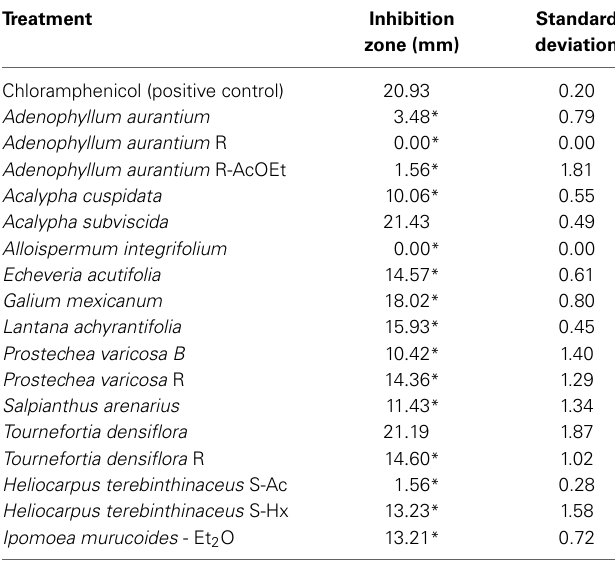
Table 4 | Toxic activity of some plants of Oaxaca against the growth of B. licheniformis